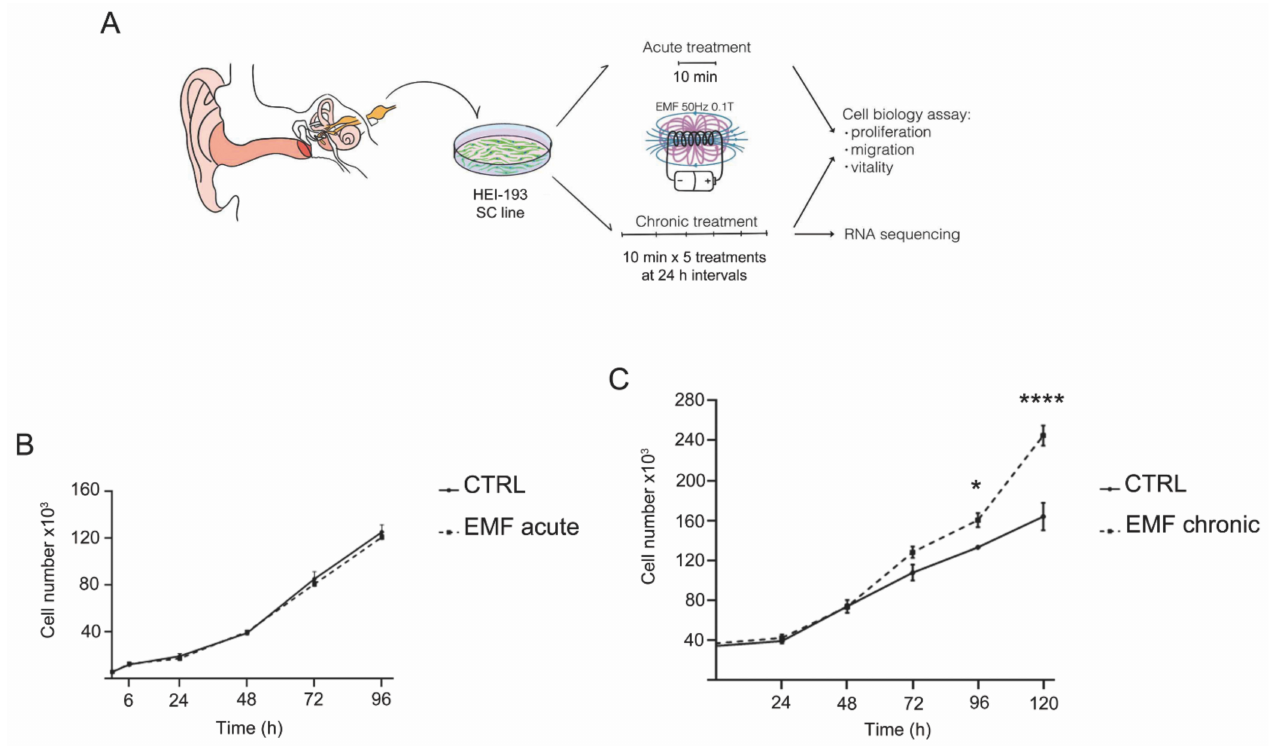
Figure 2. Proliferation effects on HEI-193 cells exposed to acute and chronic EMF. ( A ) Scheme of the experimental protocol applied. HEI-193 cells were exposed to EMF of 50 Hz, 0.1 T, for one 10-min single treatment (acute protocol) or for 10-min treatment/per day for five days (every 24 h at the same time; chronic protocol). Then, the cells were assayed for proliferation, migration, vitality, and NGS sequencing. ( B ) Proliferation was assessed at 6, 24, 48, 72, and 96 h, following a single acute EMF exposure. Experiments were repeated at least three times and data expressed as cell number ± SEM of the mean. ( C ) Proliferation was assessed at 24, 48, 72, 96, and 120 h, following a five day chronic EMF exposure. EMFs produced a significant increase in cell proliferation at 96 (* p < 0.05) and 120 (**** p < 0.0001) h. Experiments were repeated at least three times and data expressed as cell number ± SEM of the mean. Two-way ANOVA using Sidak’s post-hoc test was used for statistical